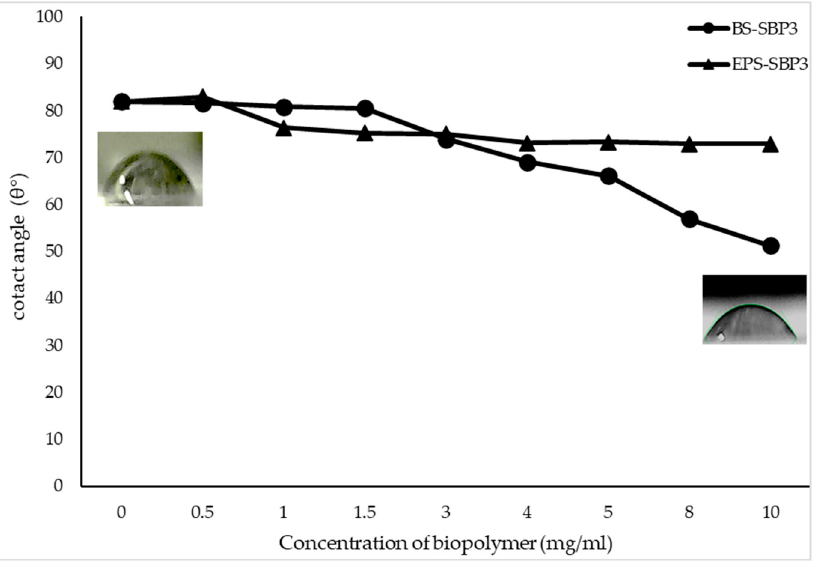
Figure 2. Contact angle of the biopolymers BS-SBP3 and EPS-SBP3 at an increasing concentration from 0 to 10 mg/mL.